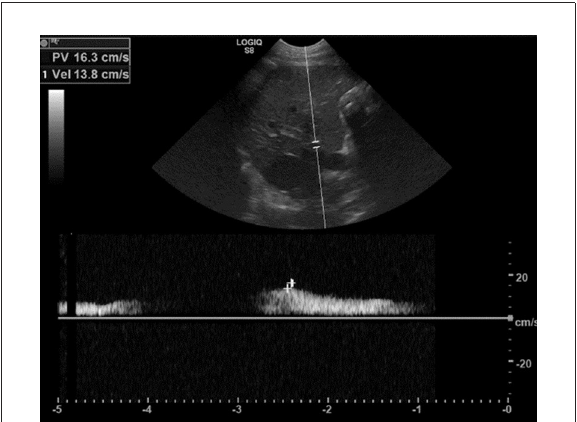
FIGURE2 Pulsed-wave Doppler interrogation of the right branch of the portal vein, indicating a portal vein velocity of 13.8 cm/s. The B-mode image with the Doppler gate is shown above. The insonation angle was < 60 ◦ for evaluation of the right branch of the portal vein in all scans. Angle correction was used as needed. The peak mean velocity was calculated using software inherent to the ultrasound machine. The measurements were obtained prior to administration of sildenafil (sildenafil citrate, ∼ 2 mg/kg as deemed appropriate by the attending clinician, per os, once) (time point 0), then 45, 90, and 120min after